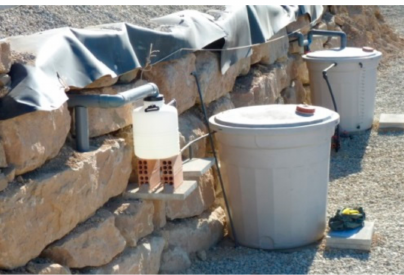
Figure 6. The two “accumulated” rainwater tanks (front) and the “punctual” rainwater tank